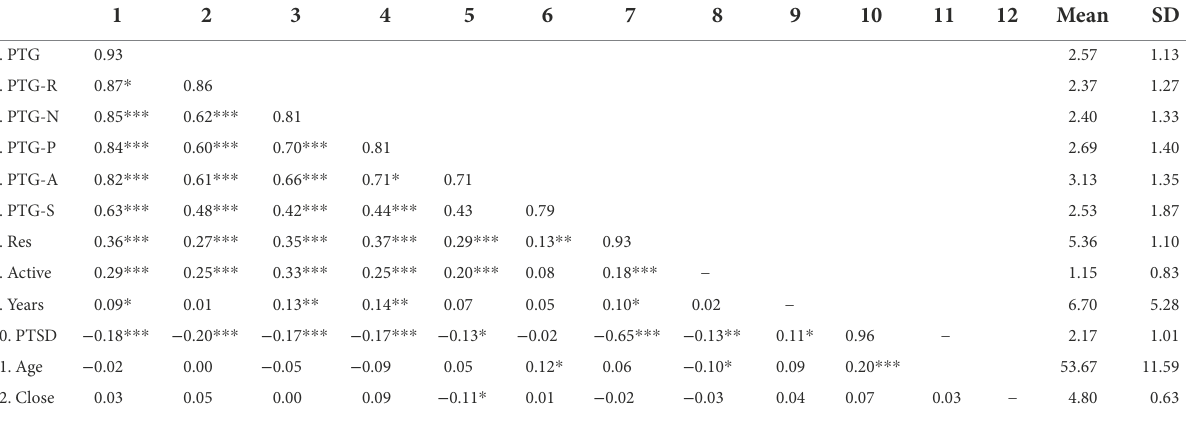
TABLE 1 Descriptive statistics and